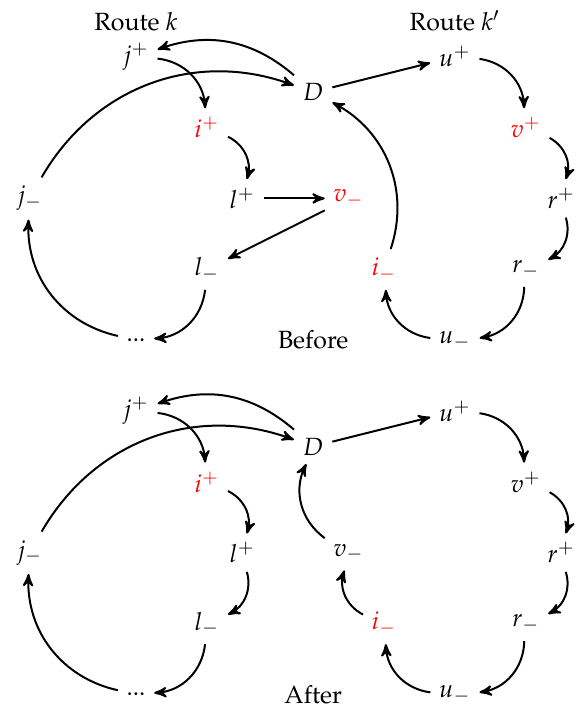
Figure 4. Repair-Destroy Inter-route Relocate